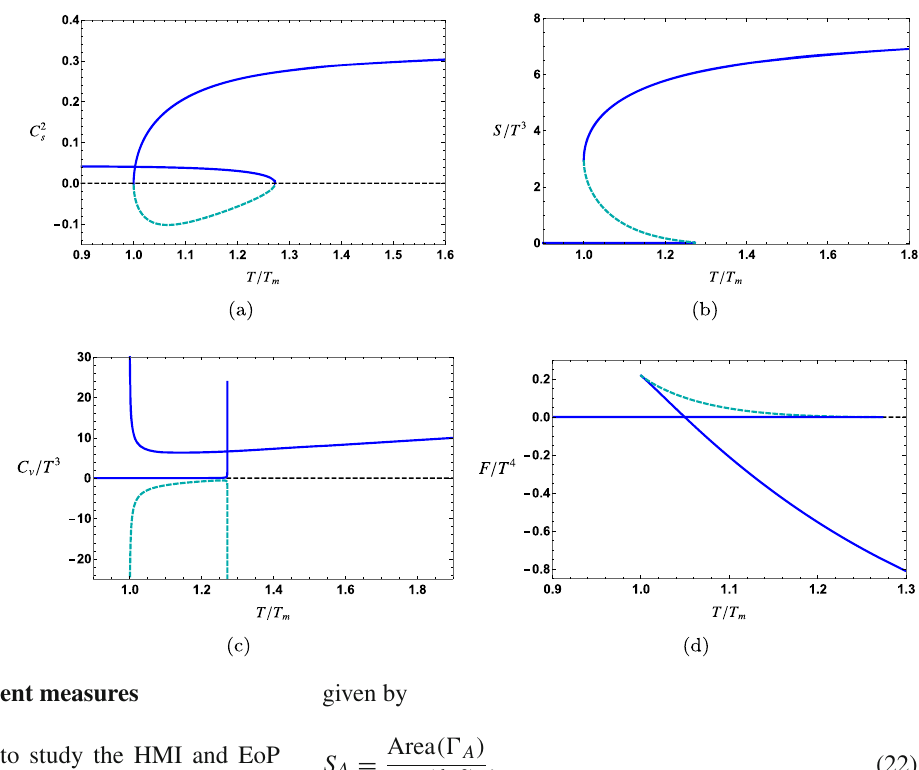
Fig. 5 The square of speed of sound c 2 s ( a ), entropy density s ( b ), specific heat C v ( c ) and free energy F ( d ) v.s. T for V 1st potential. The blue solid curves correspond to the stable black hole solution and the dashed cyan curves correspond to the unstable